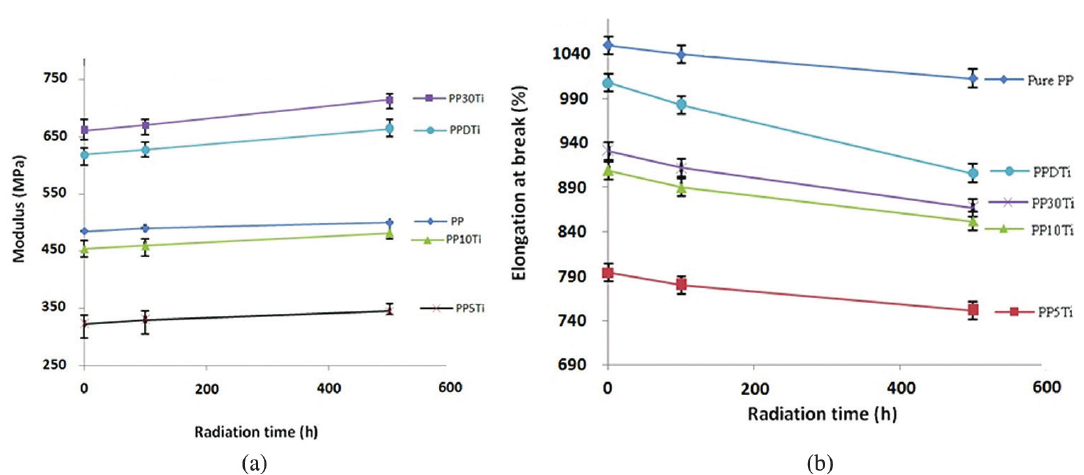
Figure 9. (a) The variations of Young’s modulus for PP Nano-composite samples with UV radiation time, (b) The variations of Elongation at break for PP Nano-composite samples with UV radiation time.